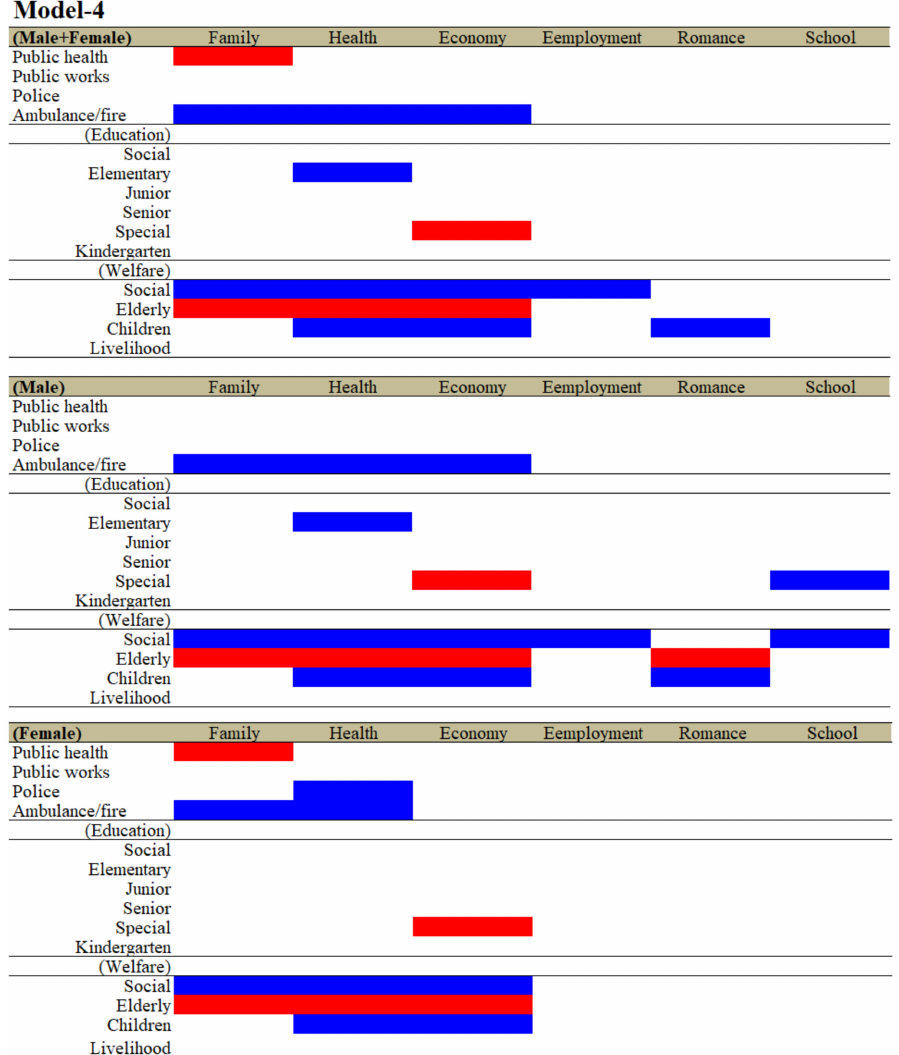
Figure 4. Relationship between financial expenditure per capita of divisions and subdivision of education and welfare of prefectures/municipalities, and suicide mortalities caused by six major motives for both genders (males + females), males and females from 2009 to 2018 using fixed- or random-effect analyses of hierarchal linear regression with robust standard error. Blue and red columns denote significant factors for decreasing and increasing suicide mortalities, respectively. The detailed statistical values are presented in Supplementary Tables